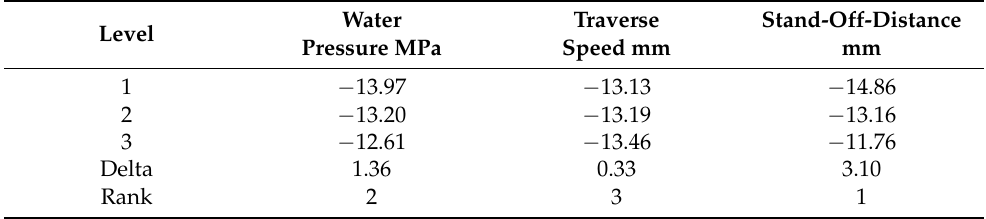
Table 18. ANOVA table for kerf taper angle response of input cutting parameters of 2 mm thickness of SPF-UPE composite cut with abrasive water jet technique .